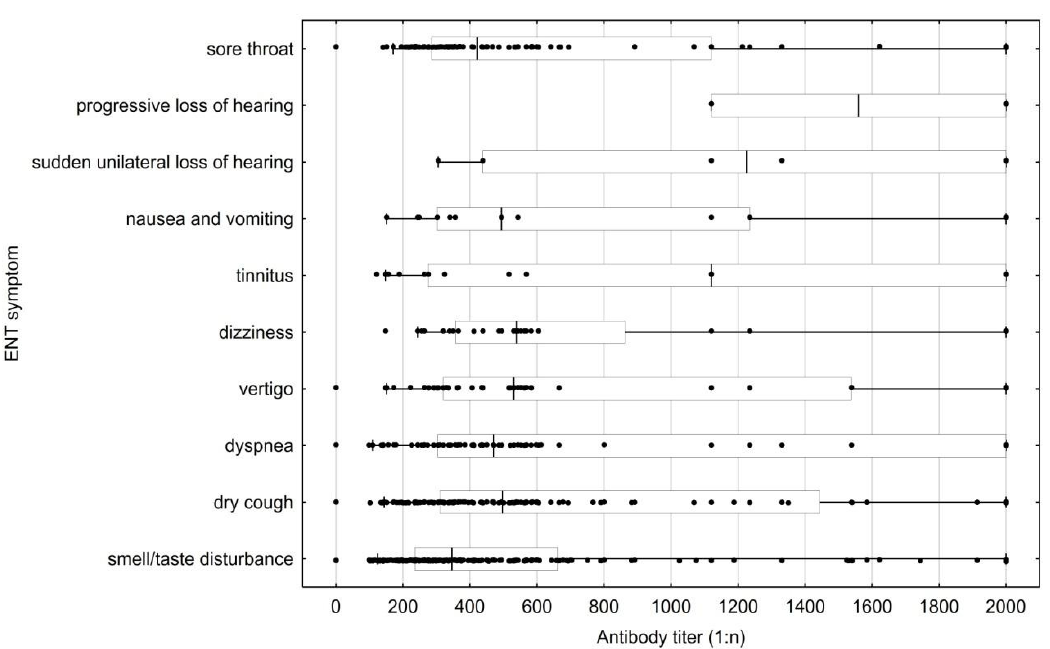
Figure 3. Antibody titer by reported ear, nose, and throat (ENT) symptom. Values for individuals with multiple symptoms are shown for each symptom individually. The center line denotes the median value (50th percentile), the box contains the 25th to 75th percentiles of the dataset, the whiskers mark the 5th and 95th percentiles, and values beyond these upper and lower bounds are considered outliers.